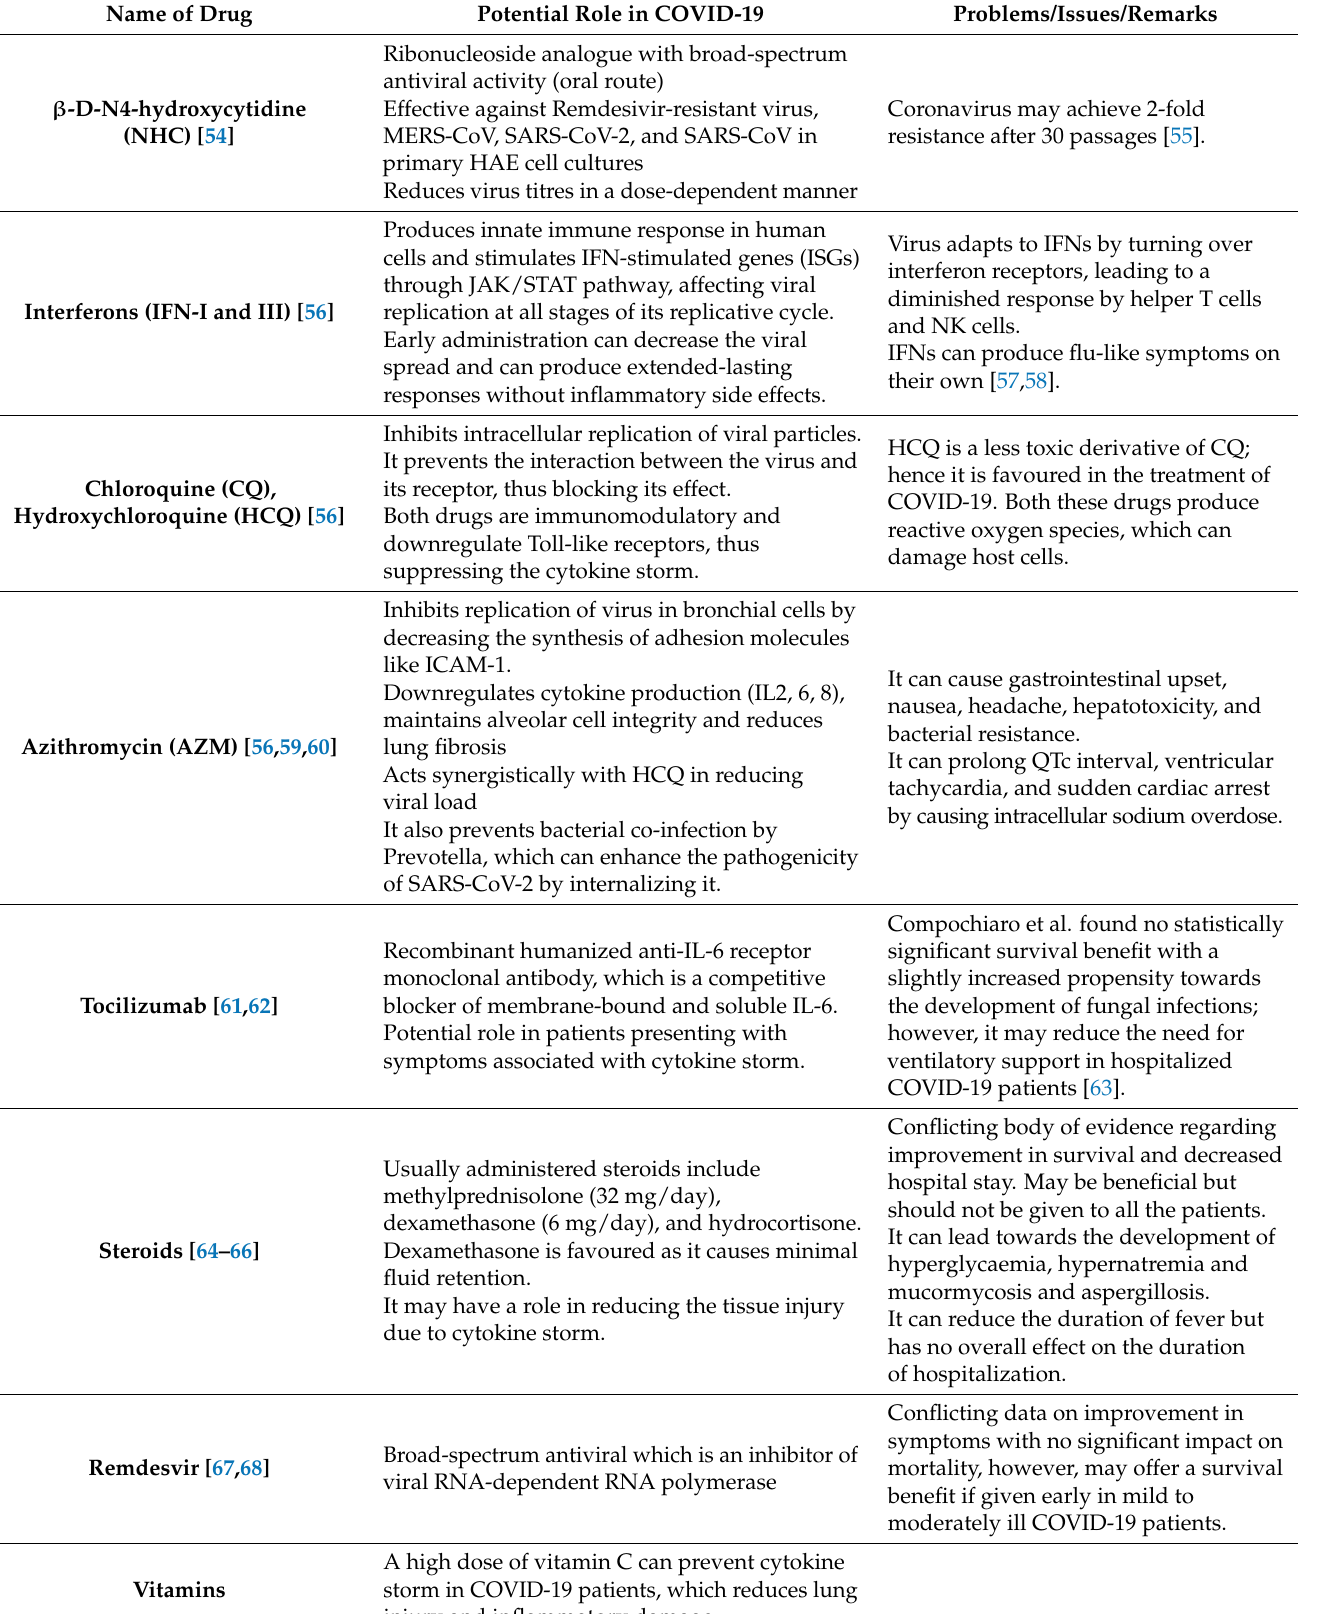
Table 4. Commonly used drugs for the treatment of